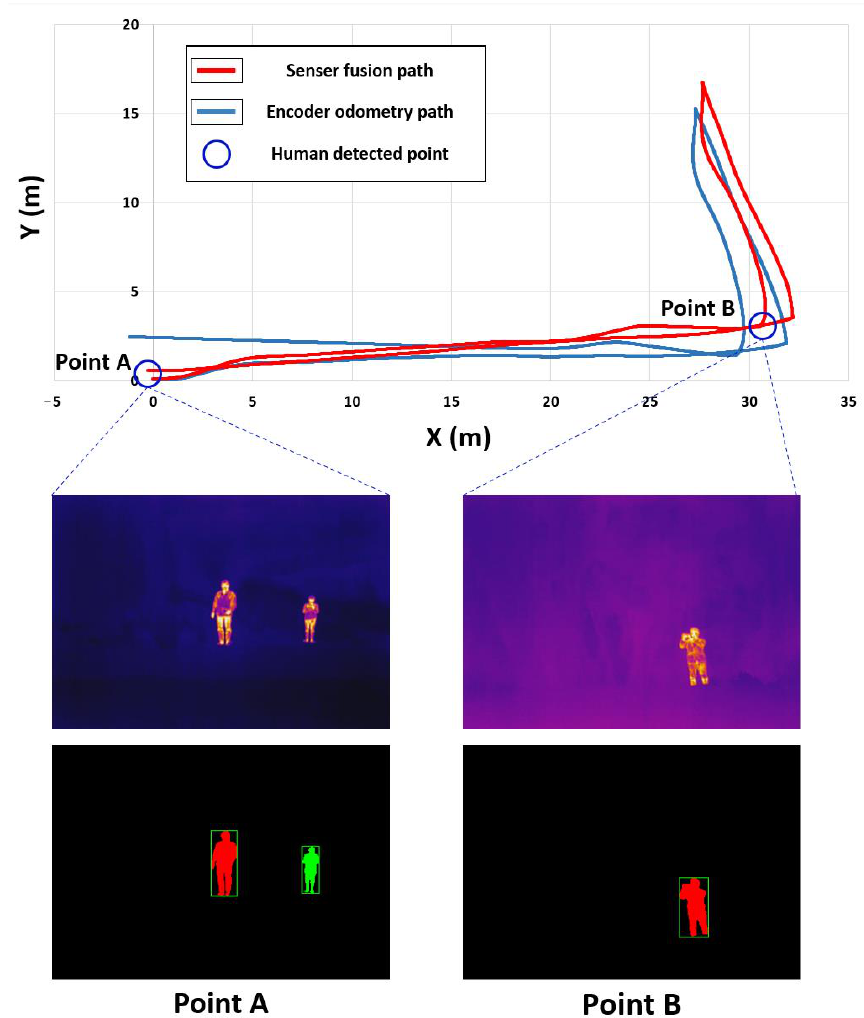
Figure 12. The robot’s driving paths estimated by the sensor fusion method and encoder odometry method, as well as the position of the human detected by thermal image and vision system. During the field experiment, the autonomous driving robot measured the concentra- tions of H 2 S, CO, O 2 , and LEL using a gas sensor; further, it measured the concentration of dust in the tunnel using a particle sensor and acquired thermal images. Hazardous factors, such as H 2 S, CO, and LEL, were not measured, and the O 2 concentration remained constant at approximately 15%. Figure 13 shows graphs of dust concentration and O 2 concentration obtained by the autonomous patrol robot during an underground mine field experiment. Figure 14 shows the particle concentration map for the experimental area. The estimated robot position coordinates and particle concentration data were aligned according to the time, and the particle concentration was visualized through color differences at the robot position points in the GIS system. In the experiment, the robot traveled to the same point twice because it first arrived at the destination and returned to the origin while passing through the same point, but only the dust data obtained while traveling to the destination was reflected on the map to prevent overlapping data display on one map. When the environmental map was created by reflecting the location coordinates of the robot on the data obtained while the robot was traveling, it was possible to intuitively visualize the dusty area and effectively examine how the dust concentration changed as the robot